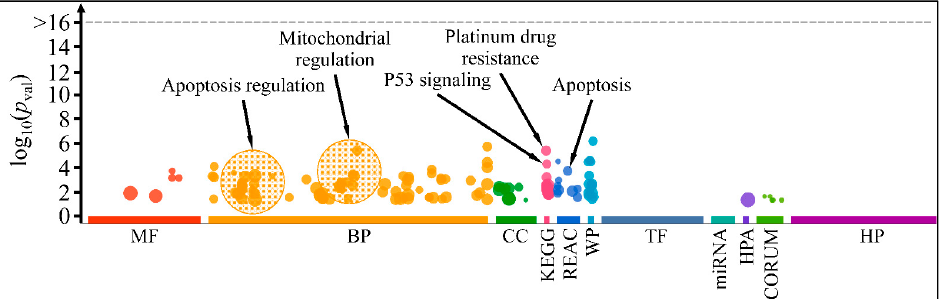
platinum drug resistance and apoptosis ( Legend : MF : Molecular function; BP : Biological process; CC : Cellular component; KEGG : KEGG pathway database; REAC : Reactome pathway database; WP : WikiPathways; TF : Transcription factor binding motifs; MIRNA : miRNA targets; HPA : The human protein atlas; CORUM : The comprehensive resource of mammalian protein complexes; HP: Human phenotype ontology).